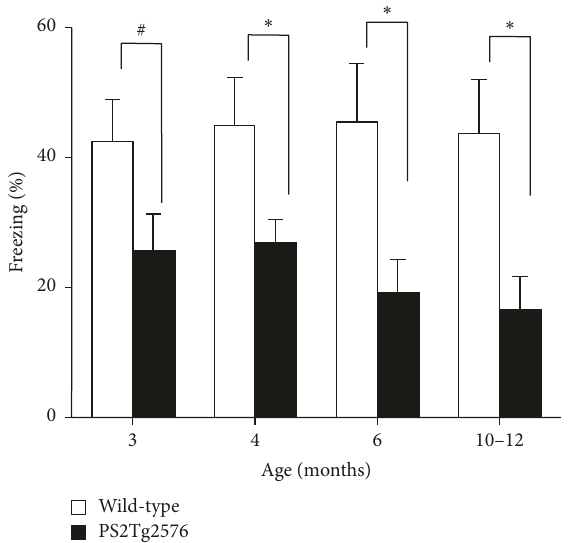
Figure 2: Progressive impairment of contextual fear conditioning in PS2Tg2576 mice with aging. The fear memory 24 hr after footshock was evaluated in PS2Tg2576 mice (closed column, 𝑛 = 10 ) and their littermate control mice (open column, 𝑛 = 10 ). PS2Tg2576 mice display impaired memory for context after fear conditioning beginningasearlyas4monthsofage,withatrendforanimpairment observed at 3 months. Data points represent the mean ± SEM. ∗ 𝑝 < 0.05 , # 𝑝 < 0.1 versus the corresponding wild-type group.